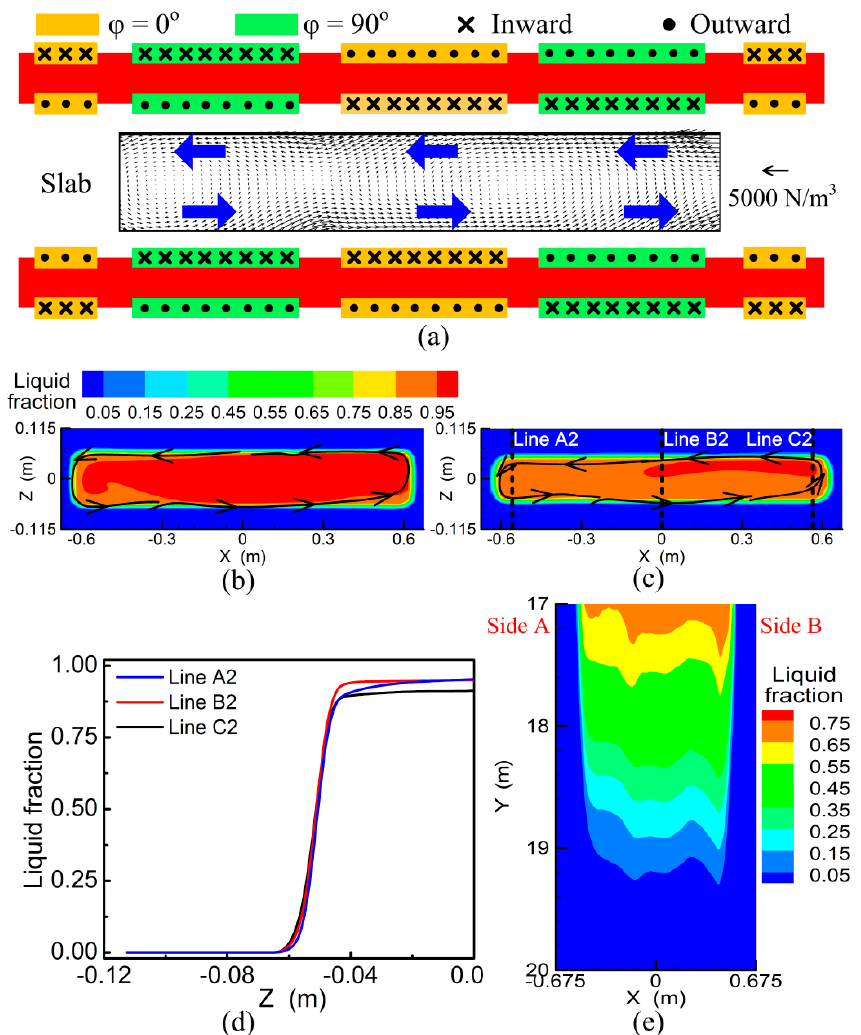
Figure 12. Electromagnetic force distribution and applied current ( a ), fluid flow and solidification at 4.4 ( b ) and 6.3 m ( c ) from meniscus, liquid fraction distribution along the transverse direction ( d ) and in the longitudinal section ( e ).